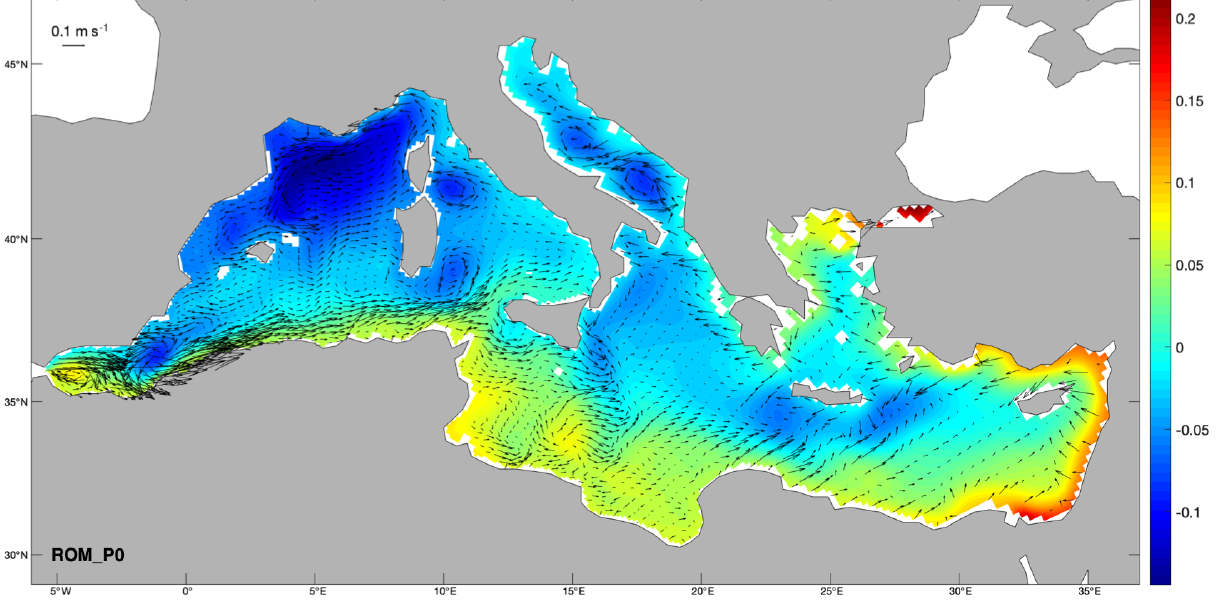
Figure 11. Mean (1980–2012) ROM_P0 SSH (m) and horizontal current velocity at 31m depth (vectors, in ms − 1 ). Only every sixth vector is